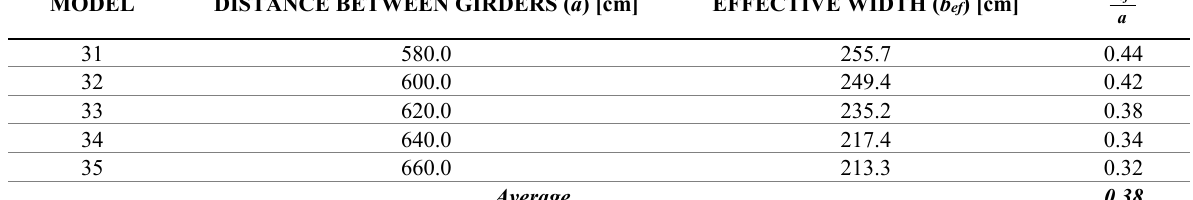
Table 9. Relationship between the effective numerical width and the distance between girders for the double box con figuration.